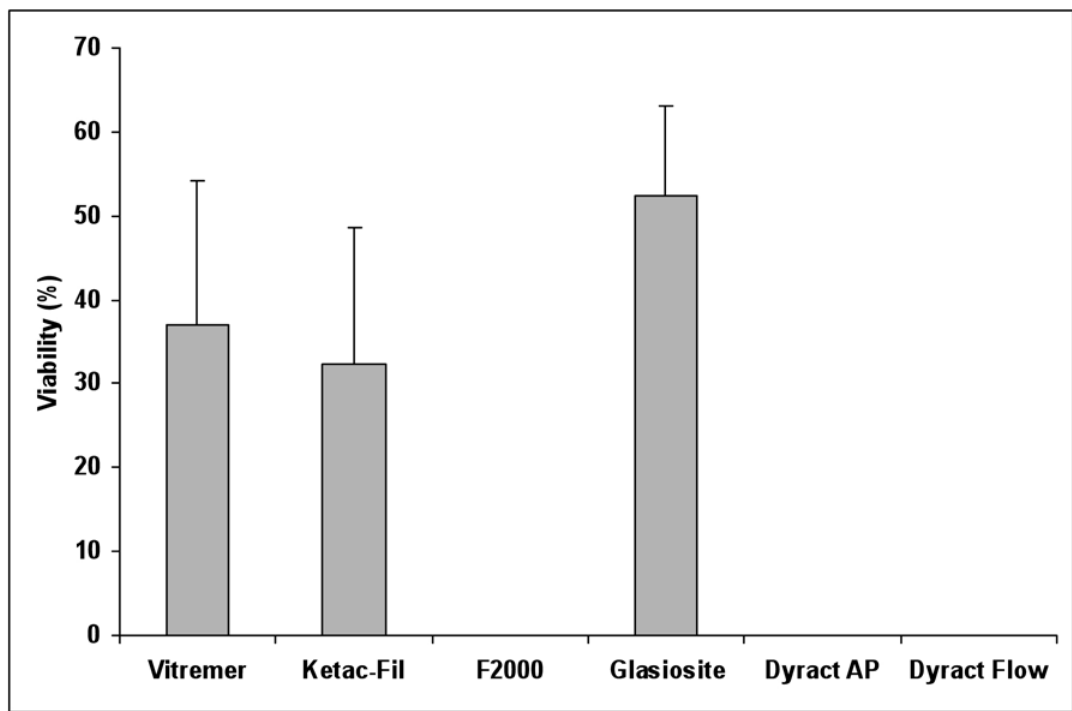
FIGURE 2- Percentage of viable brine shrimp larvae (Mean ± SD) exposed to the ethanolic extracts of the glass ionomer cements and compomers investigated in this study (brine shrimp